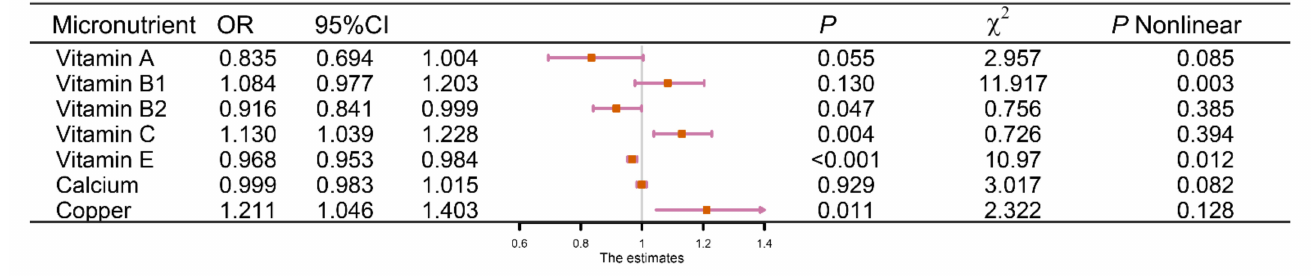
Figure 3. Result of the multifactorial logistic regression of 8 significantly micronutrients.